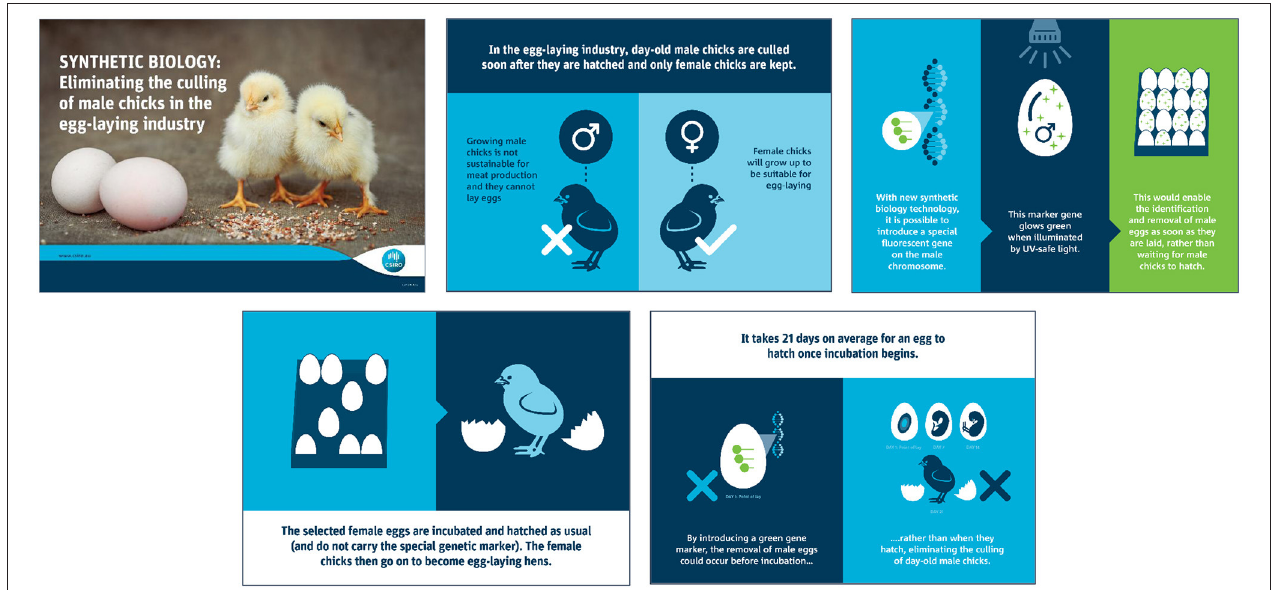
FIGURE 1 | Technology storyboard: eliminating the culling of male chicks in the egg-laying industry using synthetic biology.